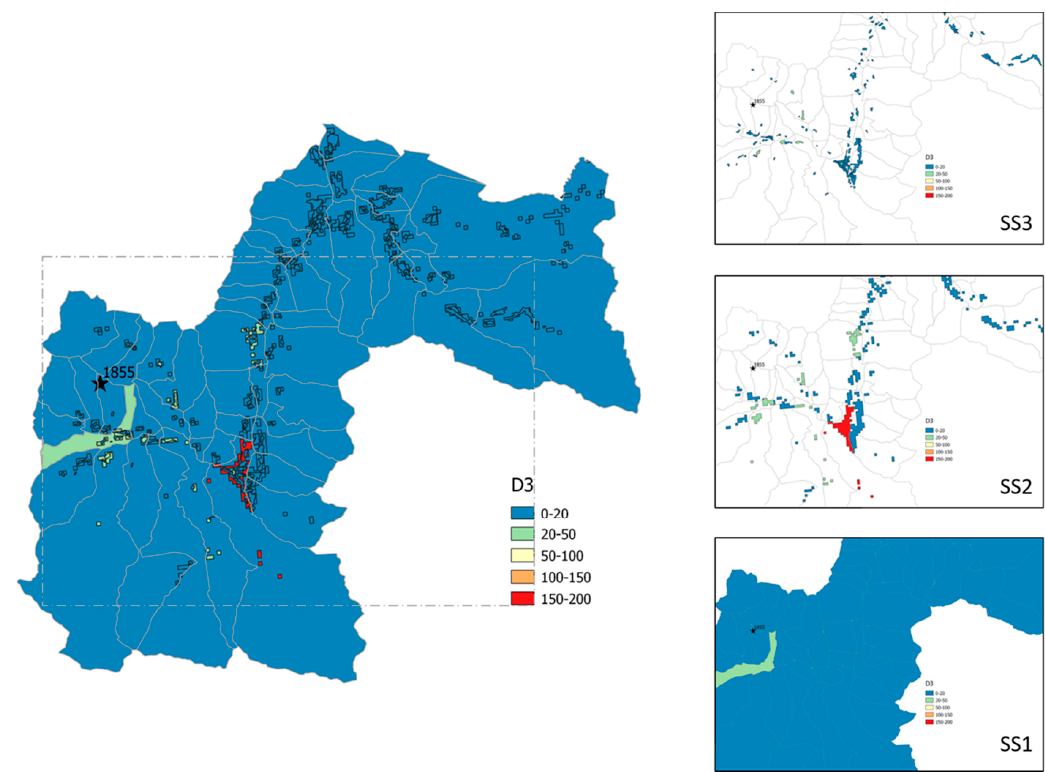
Figure 9. D3 damage distribution in the Luchon area in number of buildings, at the 53 municipalities, due to the 1855 earthquake. The site effect is considered here.